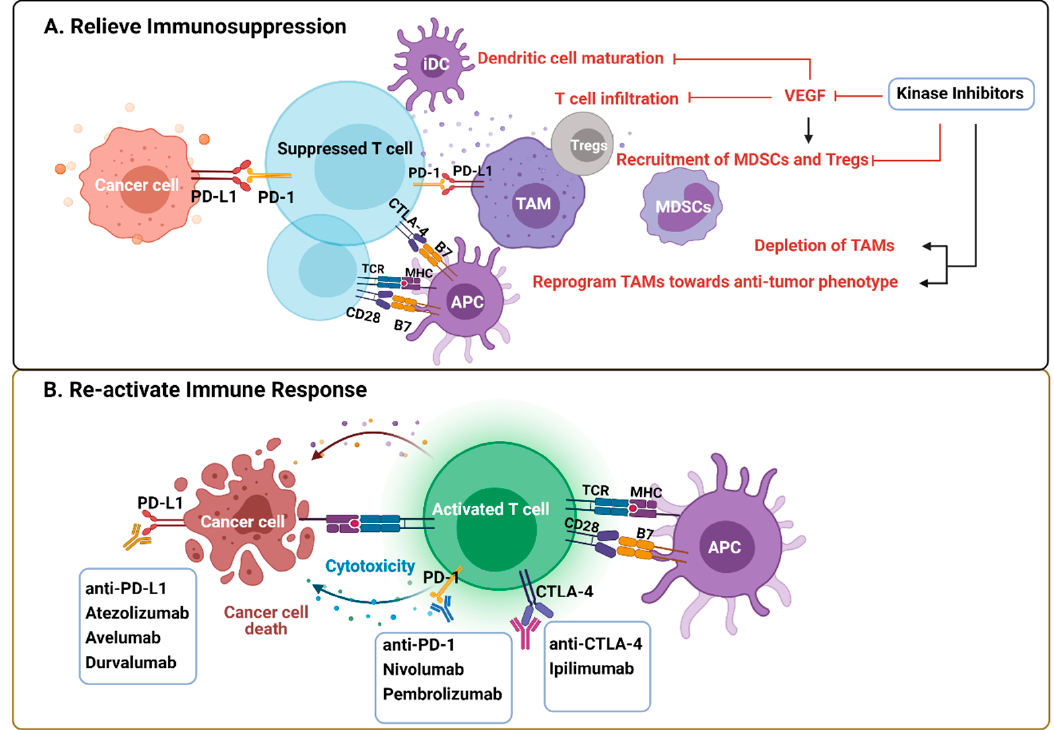
Figure 3. Rationale of kinase inhibitors and ICI combined therapies. ( A ) VEGF produced by tumor cells and immune cells creates a tumor-promoting and immunosuppressive environment by impeding DC maturation and T cell infiltration, increasing the recruitment of Tregs, TAMs, and MDSCs. KIs exert immunological effects by either blocking VEFG pathway or depleting/reprogramming the immunosuppressive cells directly. ( B ) ICI are antibodies against inhibitory pathways that block effective antitumor T cell response, including the PD-1/PD-L1 axis and CTLA-4. The rationale of the combined therapy is predicated on relief of immunosuppression within TME by KIs and re-activating T cell response by ICI. Abbreviations: CTLA-4, cytotoxic T-lymphocyte-associated protein 4; ICI, immune checkpoint inhibitors; KIs, kinase inhibitors; MDSCs, myeloid derived suppressor cells; PD-1, programmed cell death protein 1; PD-L1, programmed death-ligand 1; TAM, tumor-associated macrophages; Tregs, regulatory T cells. Created with BioRender.com.